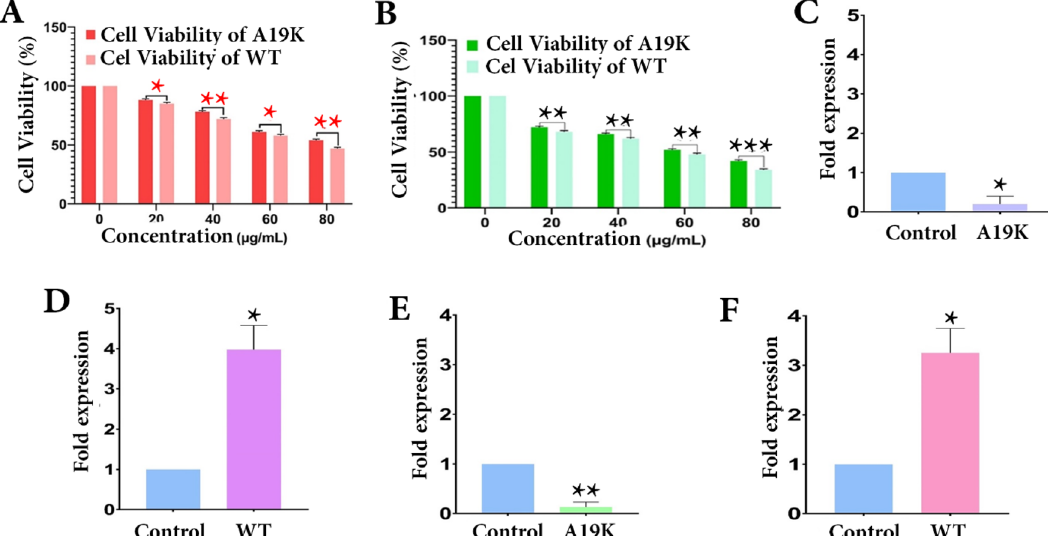
Figure 7. Effect of WT and p.A19K Brazzein on MCF-7 cell line viability. ( A , B ) The cells are treated with various concentrations (20, 40, 60, 80 μg/ml) of Brazzein and p.A19K mutant for 48 h and 72 h, respectively. Data values are expressed as % of control values. Significant change (*P < 0.05, **0.05 < P < 0.01 and ***P < 0.001) in comparison with control group). Real-time PCR analysis for TNF-α and MAP1S genes in MCF-7 cells. The values put onto each graph represent the relative fold change calculated by calibrating the ΔΔCt data TNF-α ( C , D ) and MAP1S ( E , F ) gene expressions, respectively. Error bars indicate mean ± standard deviation (SD). The significant level was define as *P ≤ 0.05 and **0.05 < P <